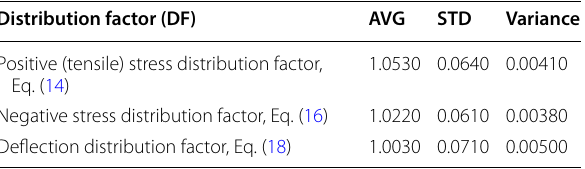
Table 3 Average, standard deviation and